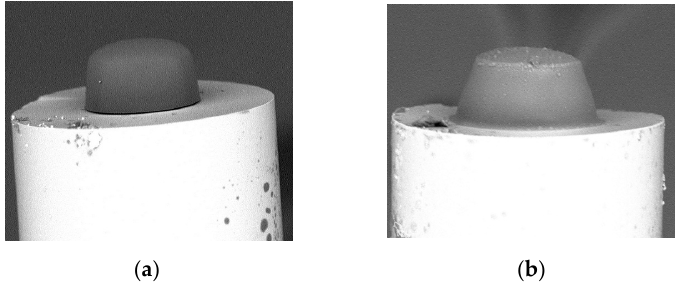
Figure 3. The SEM images of microtips manufactured with mentioned PETA monomer on MMF with a 62.5 µm core illuminated by: ( a ) UV, acetophenone PIS, P = 50 µW, t = 60 s; ( b ) VIS, Eosin Y/amine PIS, P = 20 µW, t = 60 s with respective optical powers and exposure times.